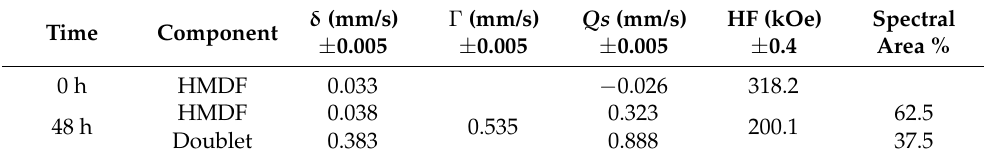
Table 3. Extrinsic magnetic properties of the Fe 90 Al 10 system with thermal treatment at 1000 °C for 7 days and milled for 24 and 48 h with oleic acid as a surfactant (the column with (Hc) corresponds to the coercive field; the column with (Mr) corresponds to the remanent magnetization; and the column with (Ms) corresponds to the saturation magnetization).